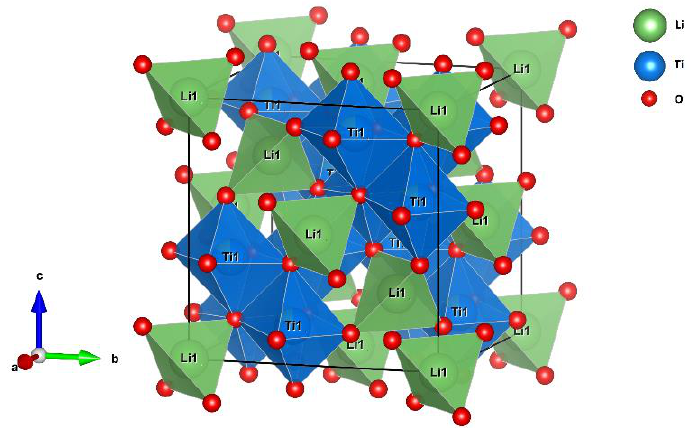
Figure 9. Unit cell of spinel Li 4 Ti 5 O 12 . The green spheres represent lithium, blue titanium and red oxygen. The Ti1 position inside the octahedra are occupied by 0.833 Ti and 0.167 Li.